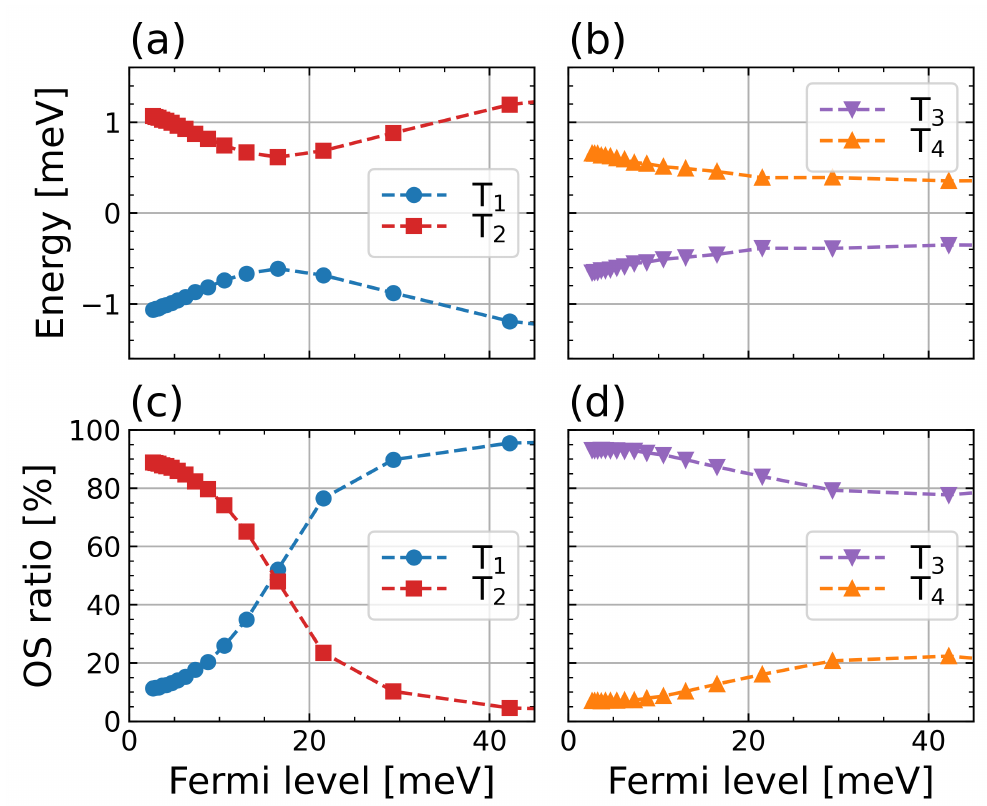
Figure 3. Doping dependence of relative transition energies of trion states T 1 and T 2 ( a ) and T 3 and T 4 ( b ) and relative oscillator strength of trion states T 1 and T 2 ( c ) and T 3 and T 4 ( d ) calculated for a free-standing MoS2 ML. The transition energies in ( a , b ) are shown with respect to their average at each doping